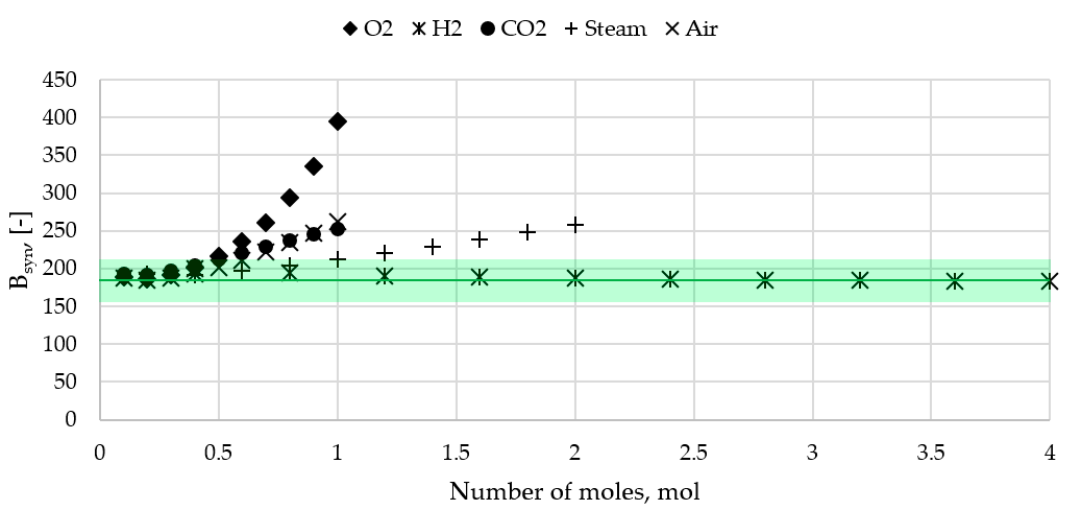
Figure 24. The B syn value for various gasifying agents and the area of applicability of an ideal gas equation with the area of 15% deviation from the value of B syn = 186.3481.